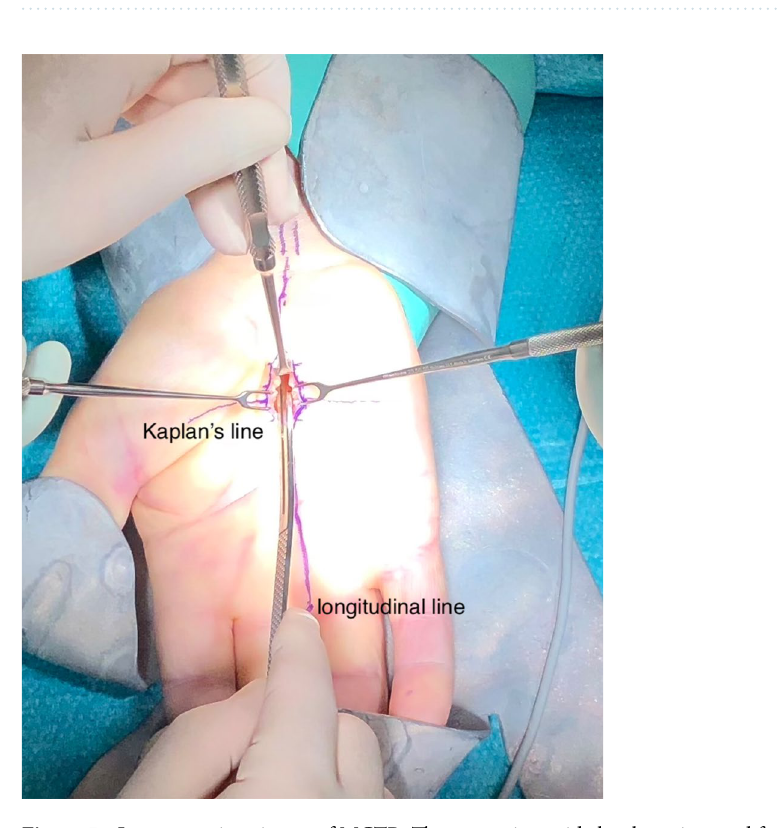
Figure 5. Intraoperative picture of MCTR: The protective guide has been inserted for protection of the median nerve. During exposure, two Fomon retractors are used transversely, one Ragnell retractor is used proximally. {SafeGuard Mini Carpal Tunnel Release System, Art.-No. 08-0001, INTEGRA LifeSciences Corporation, USA; MEDICON eG, Art.-No. 20.50.05, Art.-No. 20.12.20, Germany}. MCTR mini-open carpal tunnel